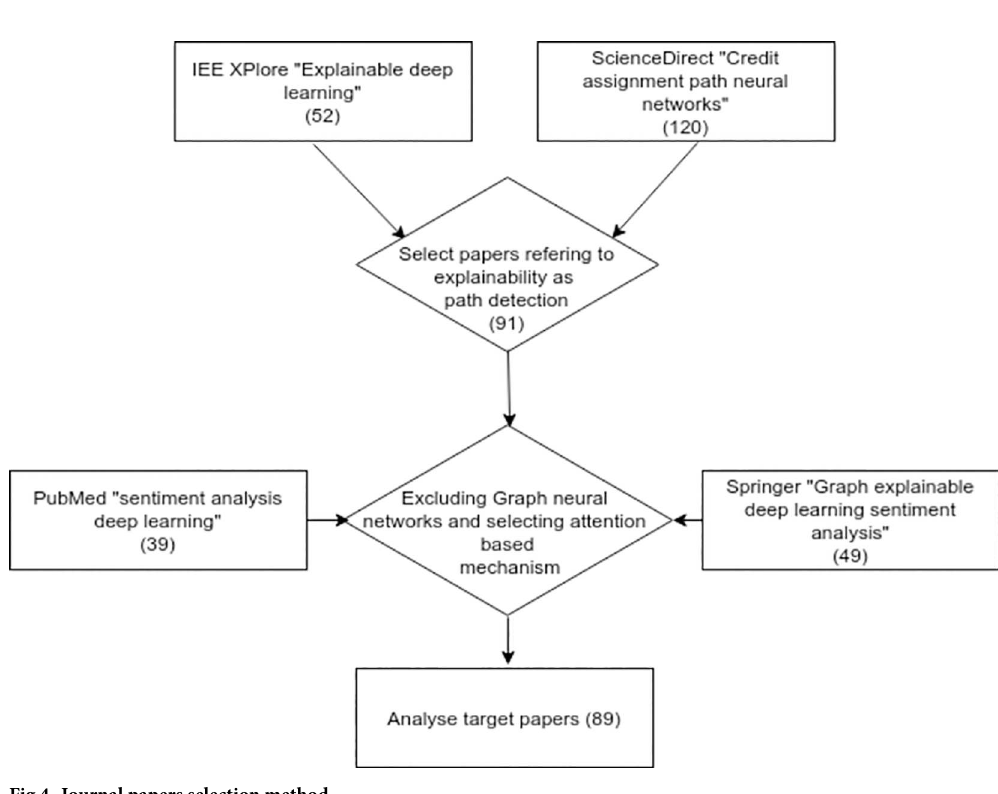
Fig 4. Journal papers selection